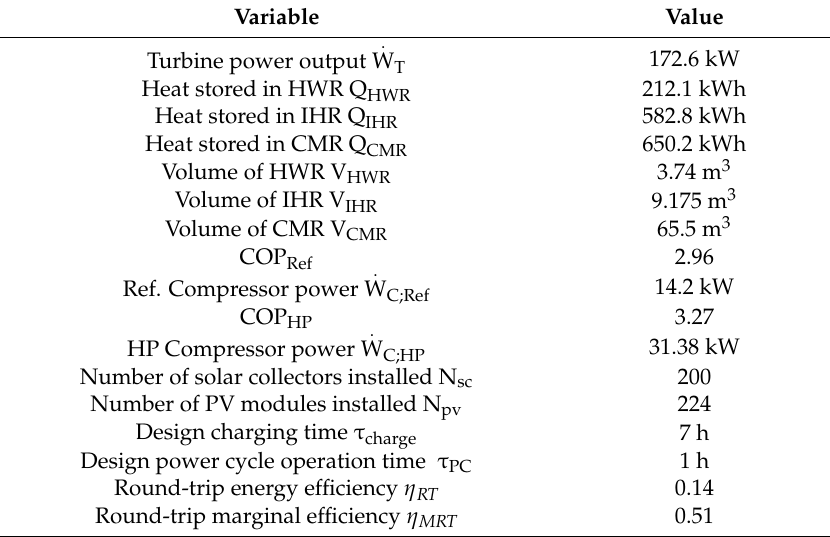
Figure 4. Distribution of meteorological data during the reference day of May in Crotone; T amb —ambient temperature, G diffuse —diffuse solar radiation, G beam —direct solar radiation. Table 5 collects the main results of the design conditions for the proposed TEES system. Table 5. Design day analysis resulting parameters.